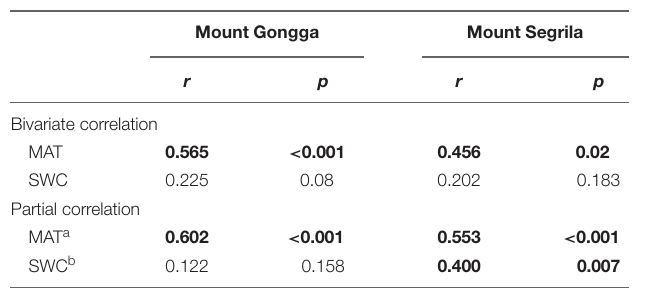
TABLE 2 | Pearson correlations ( r ) between plant (cid:2) and mean annual temperature (MAT) and soil water content (SWC) on Mount Gongga and Mount Segrila.